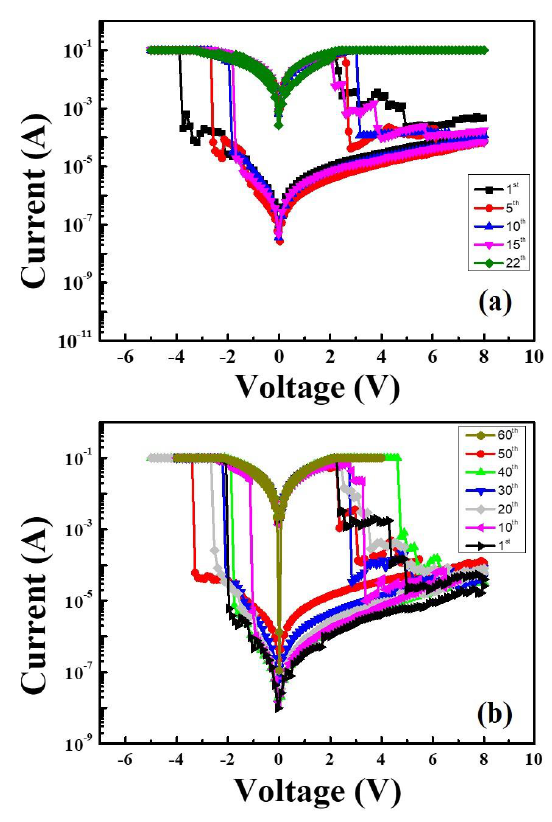
Figure 8. Switching cycles of: ( a ) Al/MZN/ITO device; and ( b ) Al/MZN NR/ITO device.